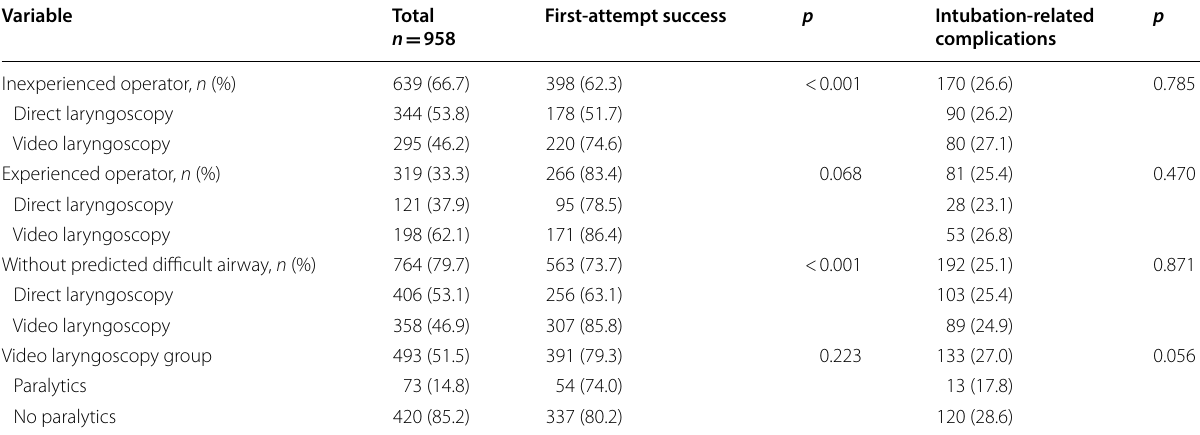
Table 7 Subgroup analysis